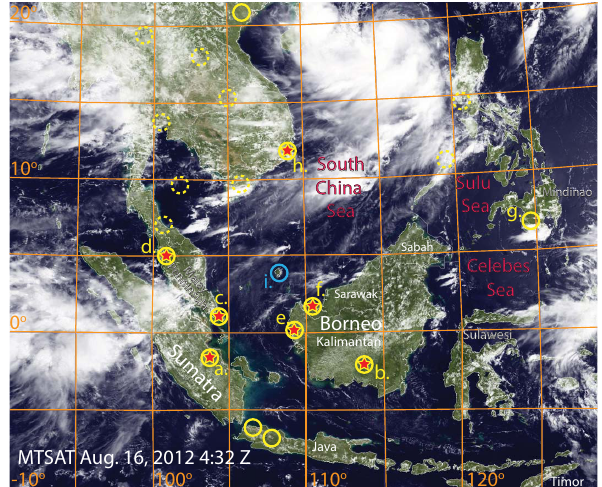
Figure 1. Map of network sites for the 2012 7SEAS southwest mon- soon intensive. Included are AERONET sites used in this analysis (yellow circles), other AERONET sites (dashed yellow circles), and MPLNET sites (red stars). Sites are (a) Jambi; (b) Palangkaraya; (c) Singapore; (d) Tahir; (e) Pontianak; (f) Kuching; (g) Notre Dame of Marbel University, Mindanao; and (h) Nha Trang. Also marked is the Riau Island radiosonde site (blue circle,